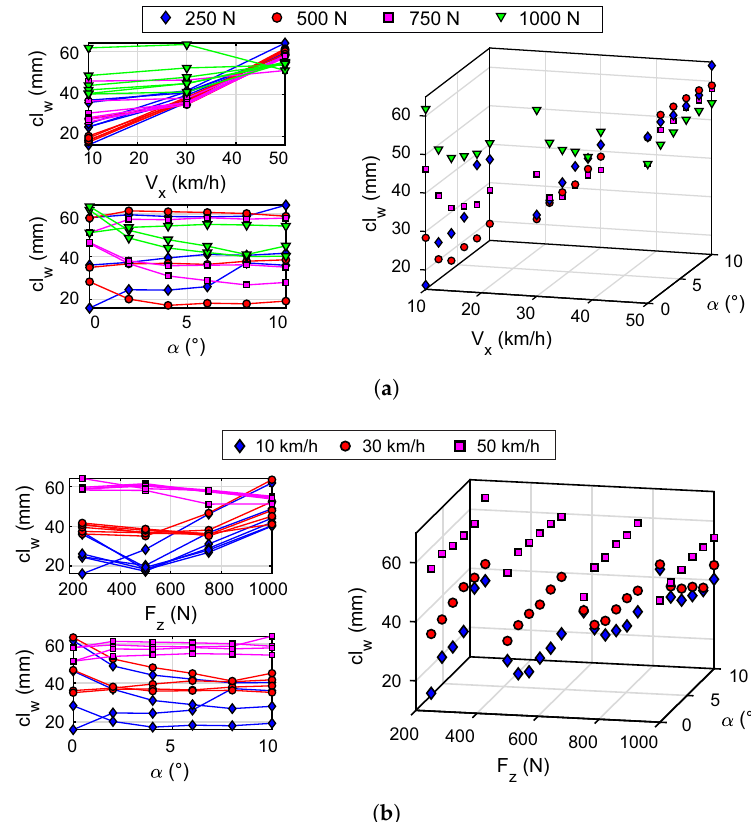
Figure 11. Contact patch results obtained by applying the proposed methodology to the experimental data. ( a ) Data differentiated by vertical load; ( b ) Data differentiated by rolling